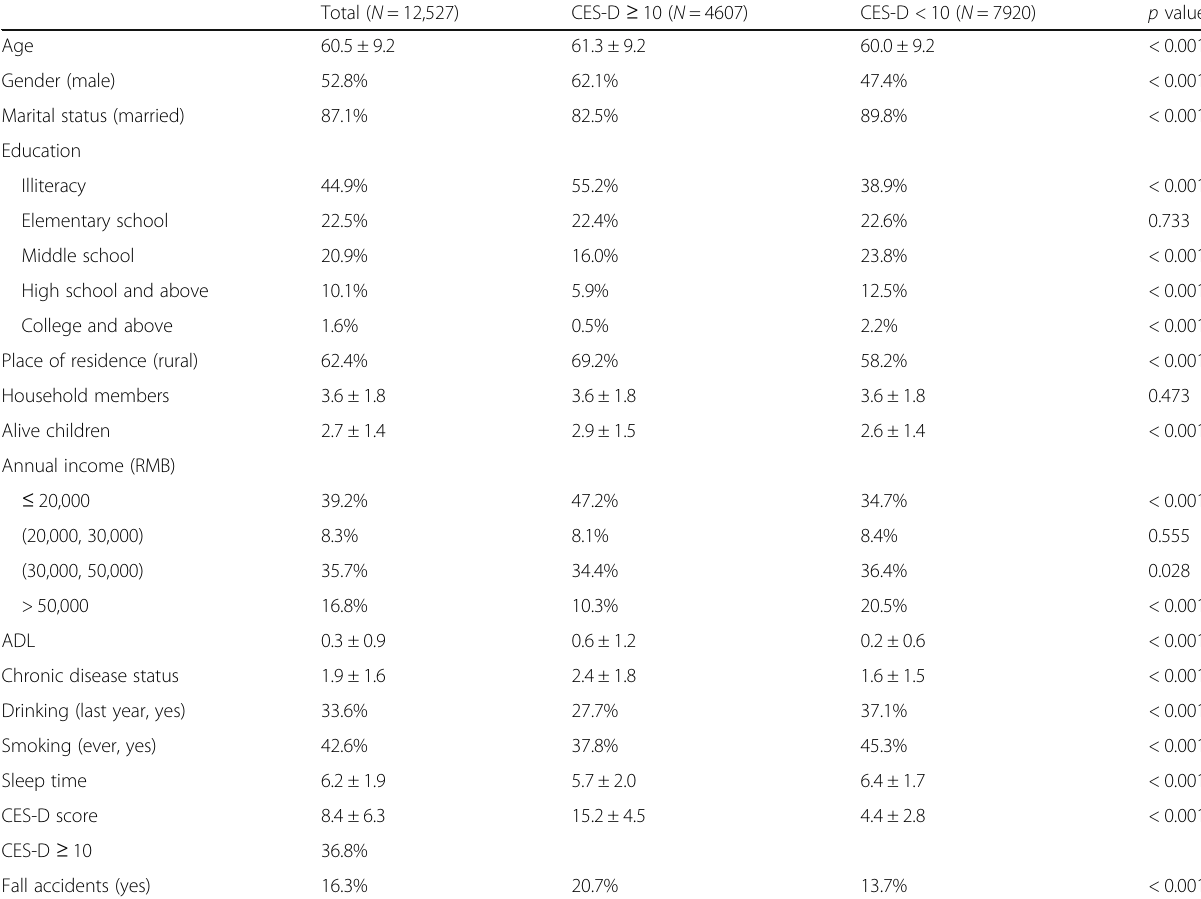
Table 2 Comparison of general characteristics of cases with CES-D ≥ 10 and CES-D < 10